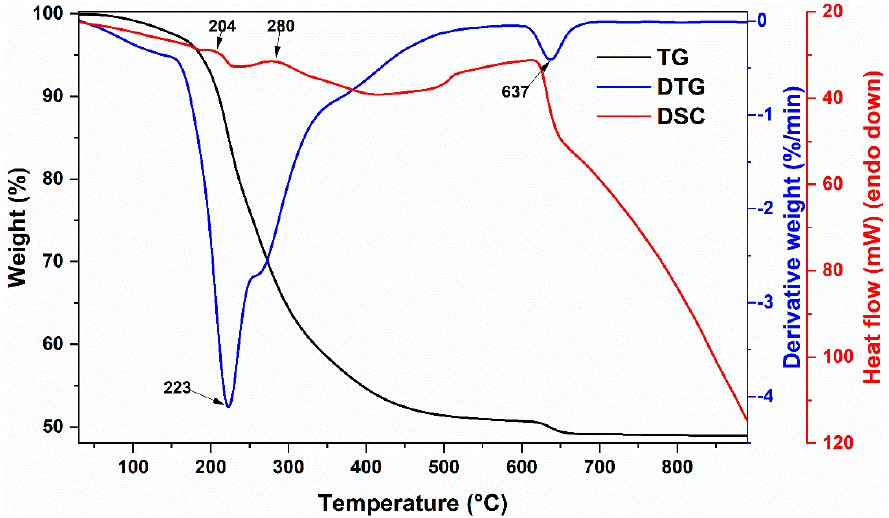
Figure 1. TG/DTG/DSC curves of (0.1)Bi-(0.9)La-(0.85)Fe-(0.15)Mn gel. Rietveld refinement was carried out for all synthesised solid solution specimens. The splitting of the most intense (200) peak was not observed for any of our samples, which means that the perovskite structure deviates from the crystal symmetry of the BiFeO 3 compound, which has a trigonal unit cell with rhombohedral or hexagonal axes. Fitting was performed with various structural models ( R3c, Pbnm, Pm 3 m, R3c + Pbnm, R3c + Pm 3 m , etc.), previously completed by Kumar and Kar [25] for Bi 1-x La x Fe 1-x Mn x O 3 (x varying from 0 to 0.3) solid solutions. They observed that the structure of all co-doped samples consists of a mixture of two different phases: orthorhombic with Pbnm space group and rhombohedral with R3c space group. In our case, the BiFe 0.85 Mn 0.15 O 3 sample has an orthorhombic unit cell with a Pbnm space group. B-site substitution with Mn 3+ [32] or Ga 3+ [33] ions can lead to identical structural transition. The compound with 10% La 3+ has an identical structure to the BiFe 0.85 Mn 0.15 O 3 sample, with a decrease in cell volume and slight variations in lattice parameters. Further increase in La 3+ up to 75% resulted in a structural change to a cubic unit cell with Pm 3 m space group. Moreover, the appearance of new diffractions peaks labelled (111), (211), (221), and (131) for a sample containing 90% of La 3+ confirms another structural transition from cubic to the orthorhombic unit cell with the Pbnm space group. Interestingly, in comparison with the solid solution with 90% of La 3+ ions, the LaFe 0.85 Mn 0.15 O 3 compound has an increase in unit cell parameters and cell volume. Analogous results were observed for Bi 1-x La x FeO 3 solid solutions, where an increase in La 3+ concentration resulted in an increase in cell parameters [34]. This was explained by the fact that Bi-containing compounds have a larger quantity of oxygen vacancies because of the lower strength of the Bi–O bond.